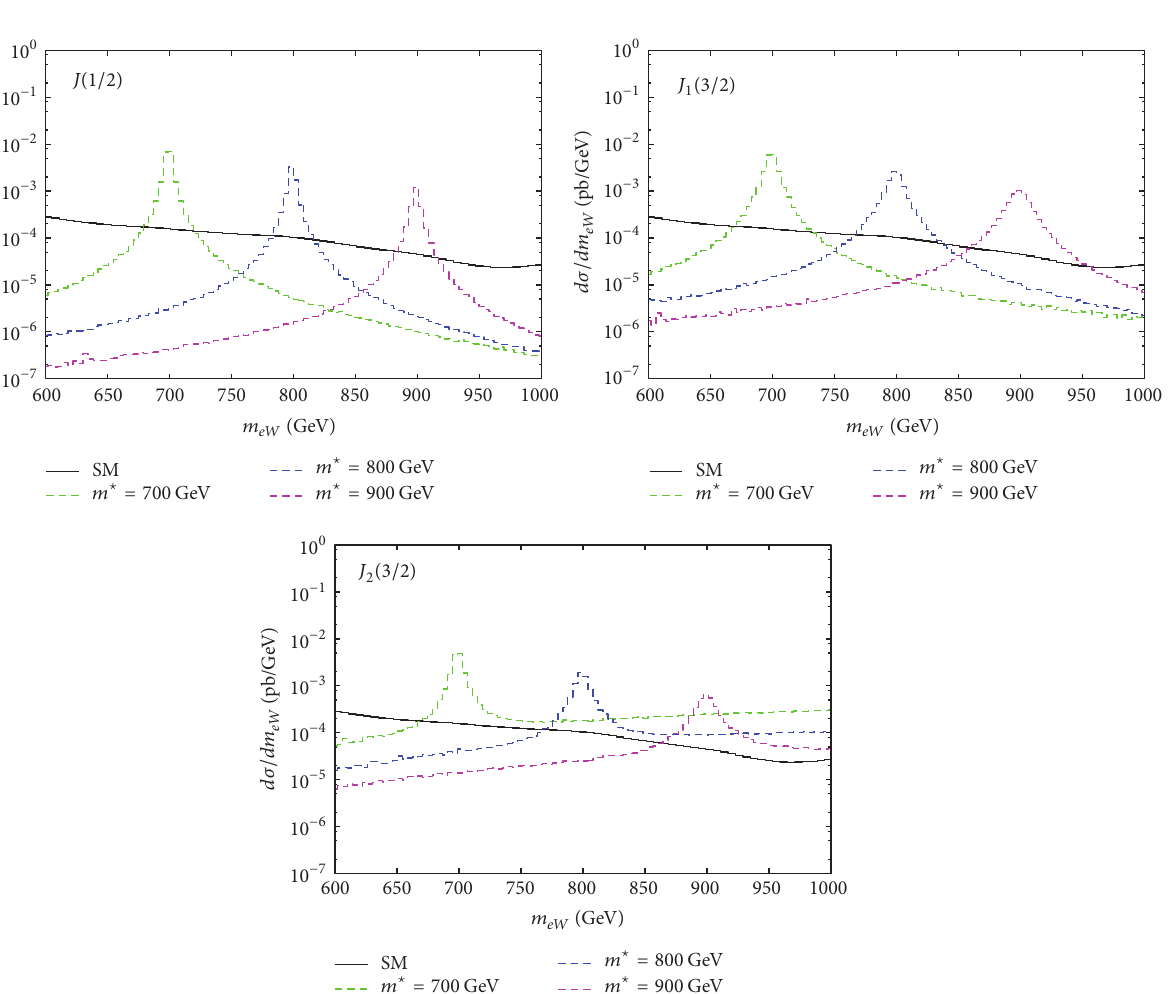
Figure 6: Invariant mass distributions of 𝑒𝑊 system for the single production of excited spin-1/2 for 𝑓 = −𝑓 󸀠 = 1 and excited spin-3/2 neutrinos with 𝐽 1 and 𝐽 2 for 𝑐 𝑖𝑉 = 𝑐 𝑖𝐴 = 0.5 ( 𝑖 = 1, 2 ) at √𝑠 = 1.98 TeV.